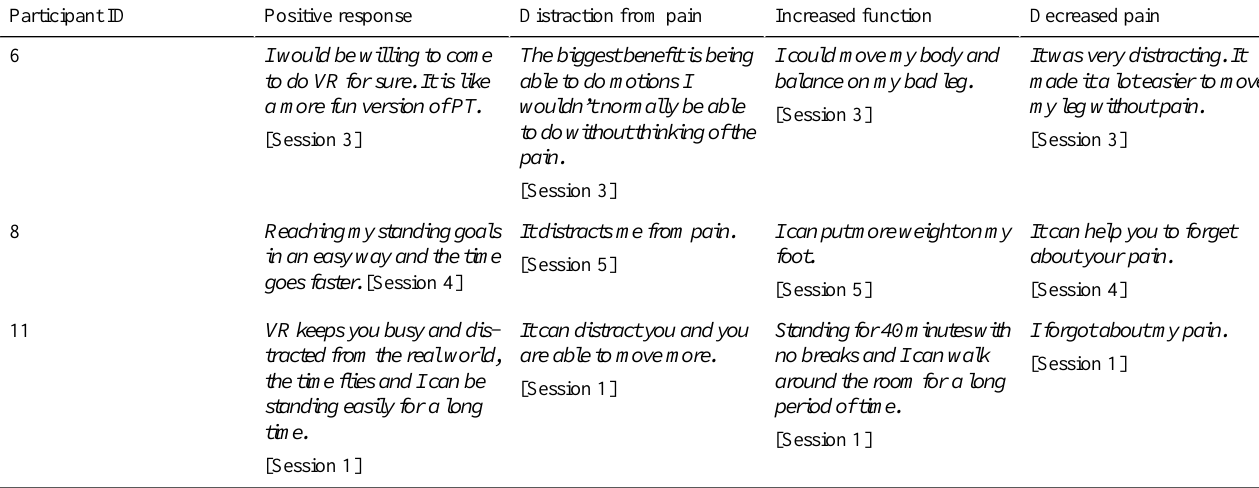
Table 1. Sample responses from participants across the 4 themes.